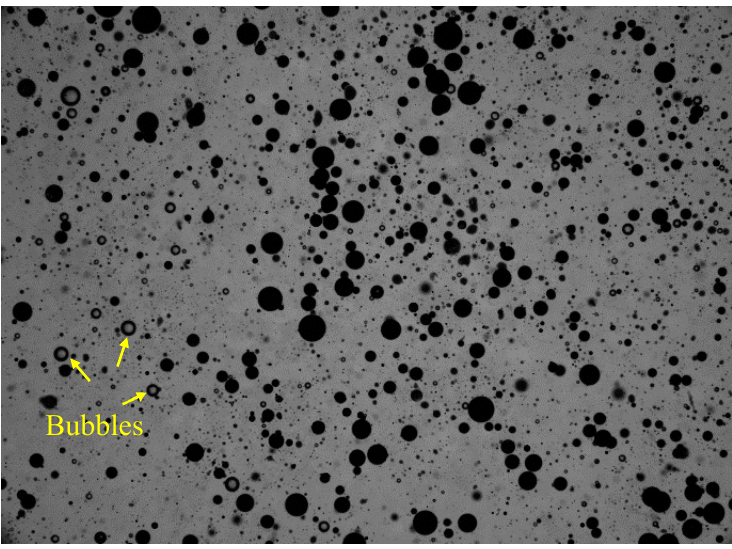
Figure 8. An example of the photos of oil droplets and bubbles taken by the shadowgraph camera. The dark disks represent droplets of di ff erent diameters, and the hollow circles illustrate the air bubbles.